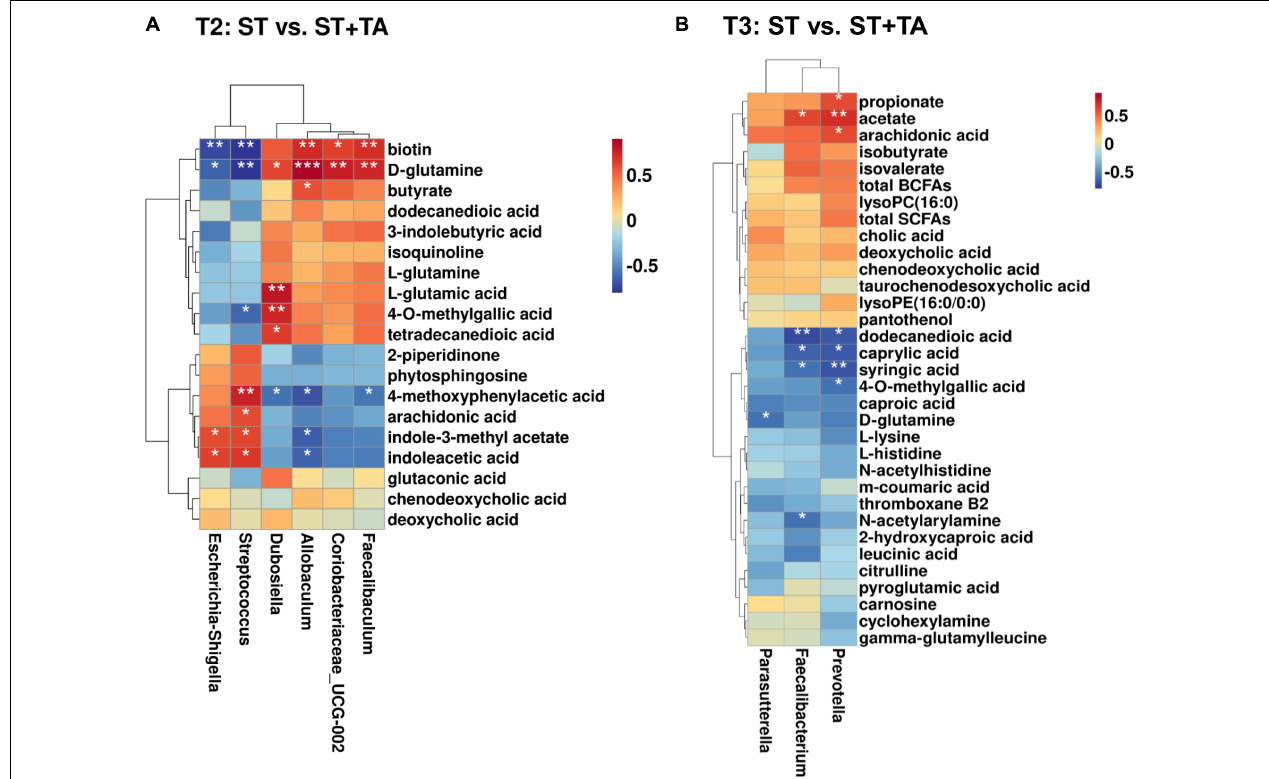
FIGURE 9 | Correlation heatmap between differential metabolites and fecal bacteria (at the genus level) at T2 (A) and T3 (B) . The symbol (*) indicates a significant correlation between serum metabolites and fecal bacteria (* p < 0.05, ** p < 0.01, and *** p < 0.001). Red color indicates a positive correlation, and blue color indicates a negative correlation. T2, day 8 after transportation; T3, day 14 after